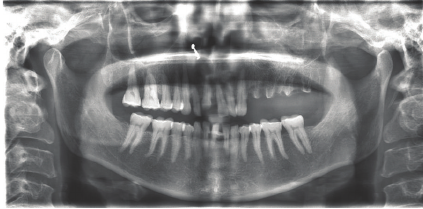
Figure 3: Orthopantomogram reveals missing teeth (24, 25, 26, 27, and 28) with unhealed sockets.